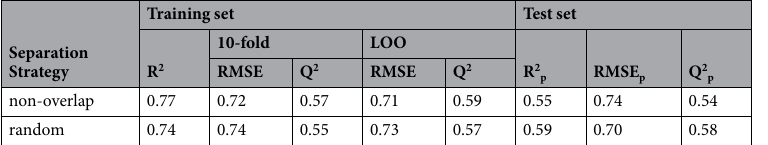
Table 6. Comparison of performances between the non-overlap and the random